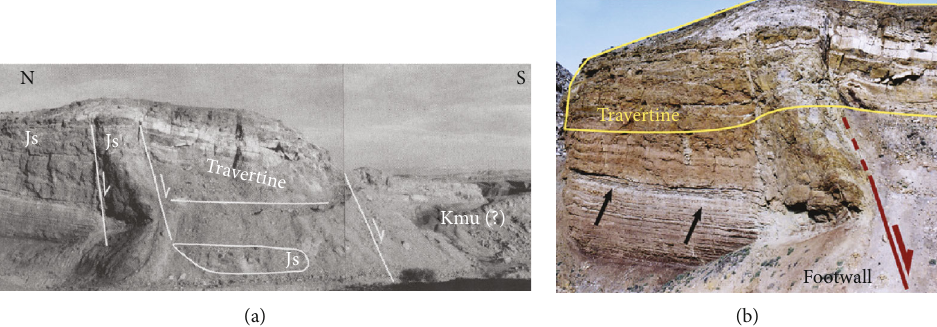
Figure 6: Photographs of vertical exposures of the northern and southern primary faults and surrounding damage zone of the Little Grand Wash Fault. The location of these photographs is indicated in Figure 3. (a) A photo of the primary fault splays of the Little Grand Wash Fault. The fault core is the narrow feature enclosed by two fault surfaces. Js: Jurassic Summerville Formation; Kmu: Cretaceous Mancos Shale (from Shipton et al. [14], Figure 5(a)). (b) Closeup of the clay-rich fault core and surrounding damage zone of the northern fault splay. The elevated erosion-resistant fault core is intruded/draped by the paleotravertine (from Dockrill and Shipton [3], Figure 5(d)).